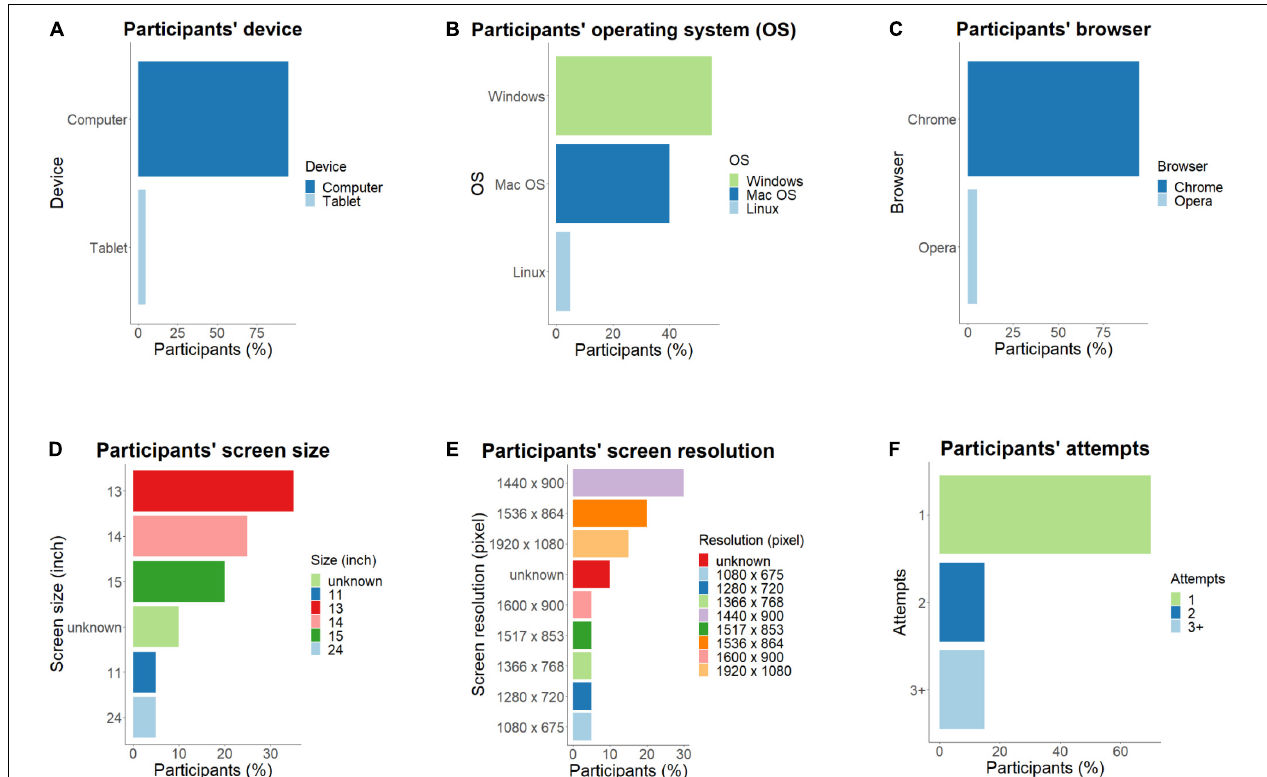
FIGURE 4 | Technical specifications in the online experimental setting. Participants’ devices and equipment were assessed, including (A) device type; (B) operating system; (C) browser; (D) screen size; (E) screen resolution; as well as (F) feasibility of launching the study (number of attempts to complete the